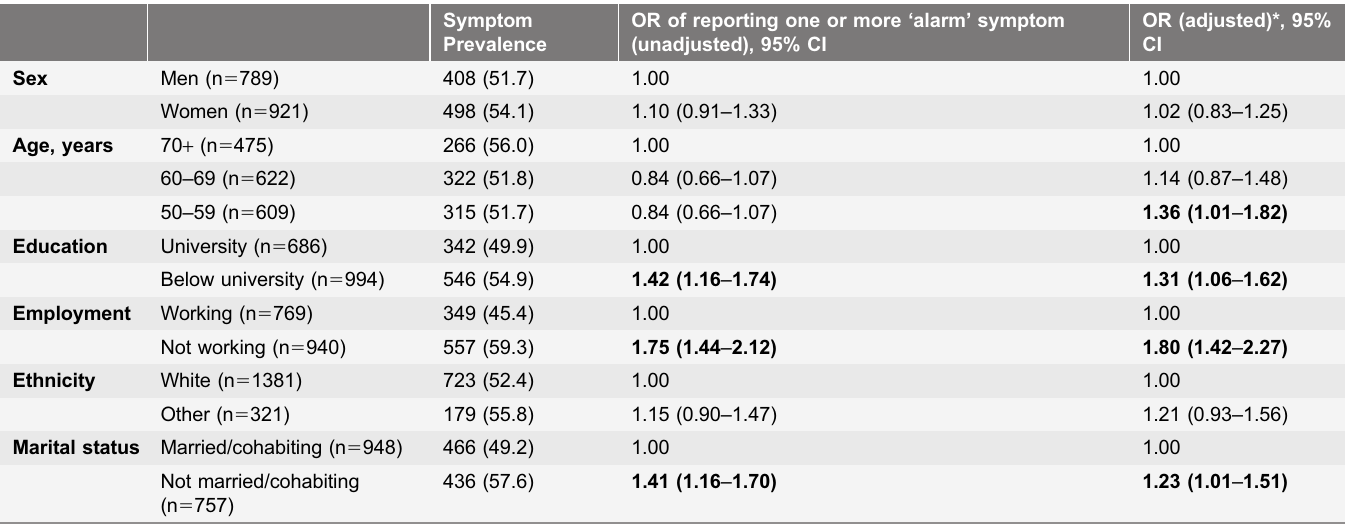
Table 2. Prevalence, unadjusted and adjusted odds ratios of reporting one or more cancer ‘alarm’ symptom in the past 3